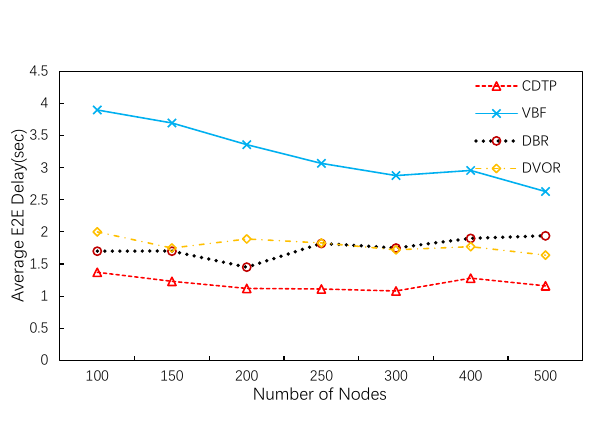
Figure 10. Average E2E